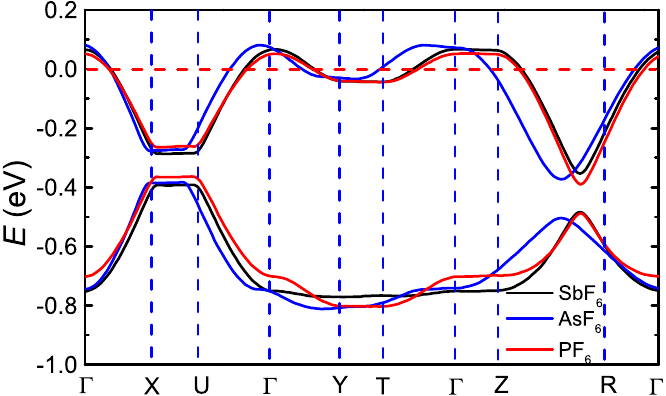
Figure A1. Comparison of the band structure of (TMTTF) 2 X , X = PF 6 (red), AsF 6 (blue), and SbF 6 (black) at room temperature along the k -path: Γ ( 0,0,0 ) → X ( 0.5,0,0 ) → U ( 0.5,0.5,0 ) → Γ ( 0,0,0 ) → Y ( 0,0.5,0 ) → T ( 0,0.5,0.5 ) → Γ ( 0,0,0 ) → Z ( 0,0,0.5 ) → R ( 0.5,0.5,0.5 ) → Γ ( 0,0,0 )